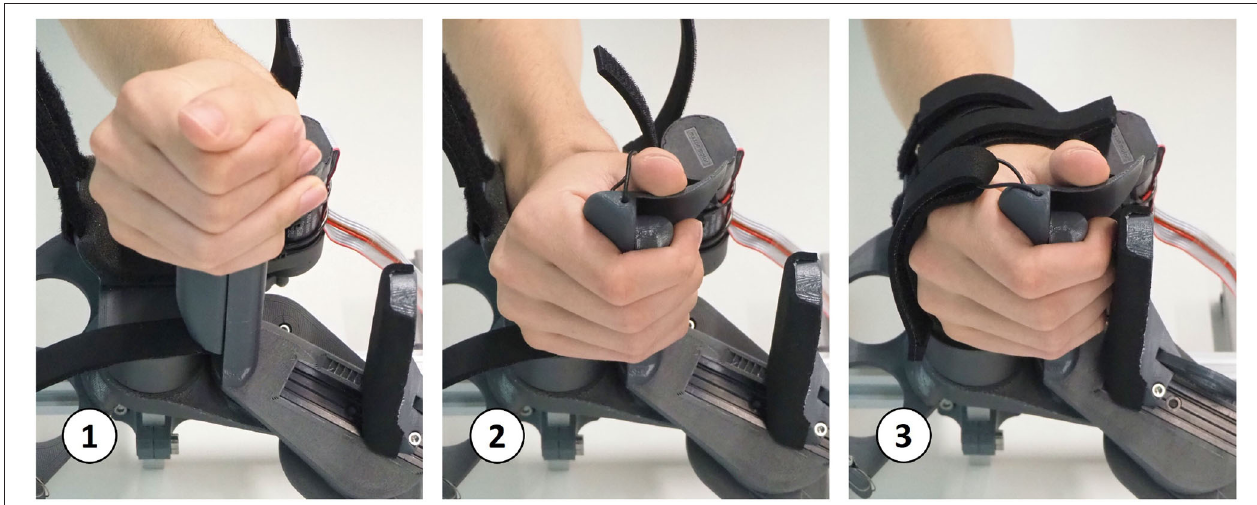
FIGURE 12 | Setup sequence: a hand with flexed fingers can easily be slid onto the handle. Then, within a few seconds, the wrist and hand straps can be tightened and the fingertip fixation can be adjusted.